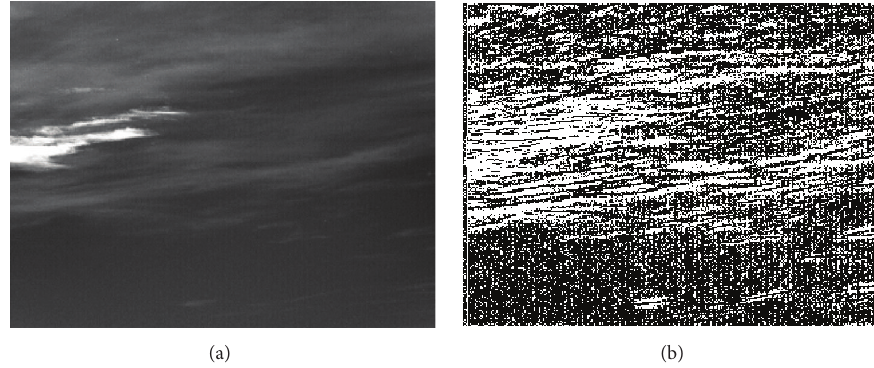
Figure 6: Structure background removing. (a) Infrared scene. (b) Structure background removing.